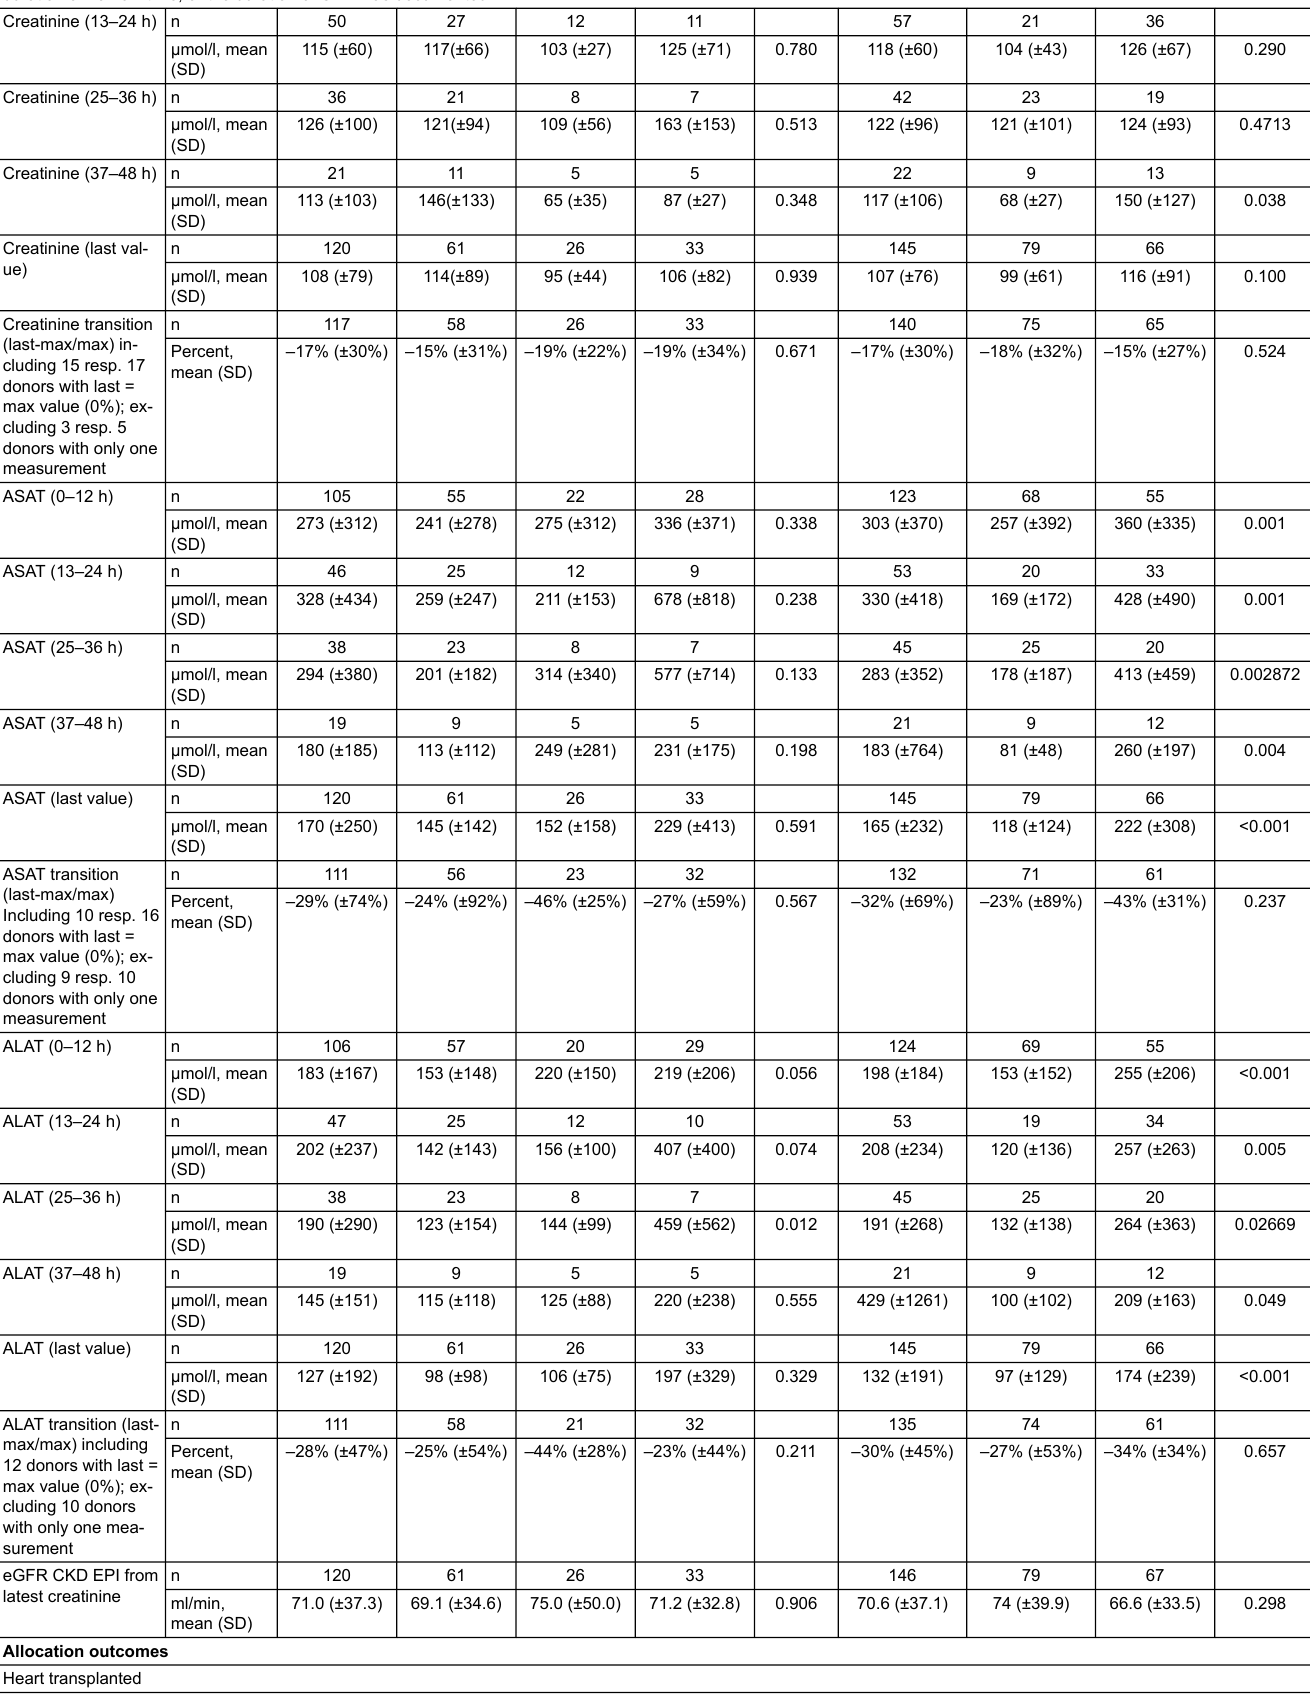
Table S1: Complete table for the analysis of the effect of CPR duration and no-flow time; included are only utilised donors (at least one organ transplanted) for whom either the duration of no-flow time, or the duration of CPR was